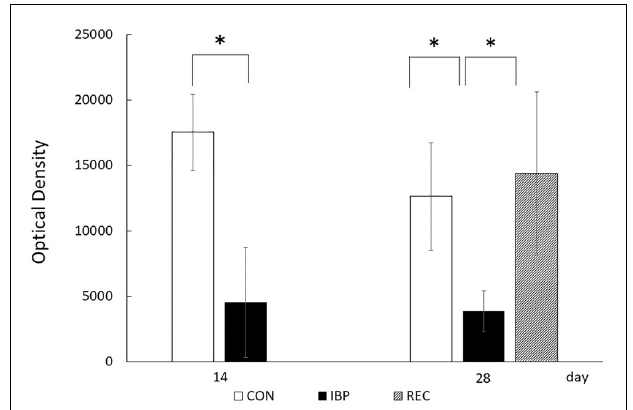
FIGURE 4 | The area of acinar cell. Morphometric measurements of acinar cells of the SMG. The area occupied by one acinar cell was calculated by dividing the acinar area by the number of acinar cells in that acinus. Data are presented as the mean ± standard deviation ( n = 6 each, * p < 0.05).